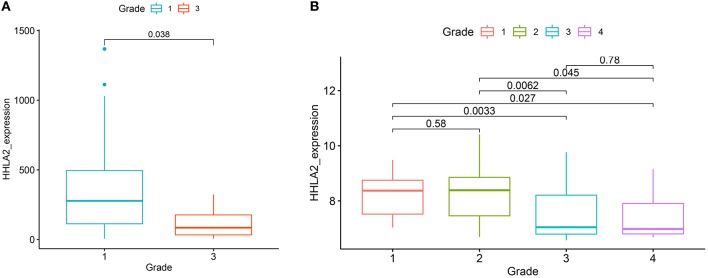
The boxplot shows the correlation between the expression of HHLA2 and the pathological grade in KIRC (left:from GSE22541, right: GSE40435). The label at the top of the picture corresponds to the pathological stage of the patient.